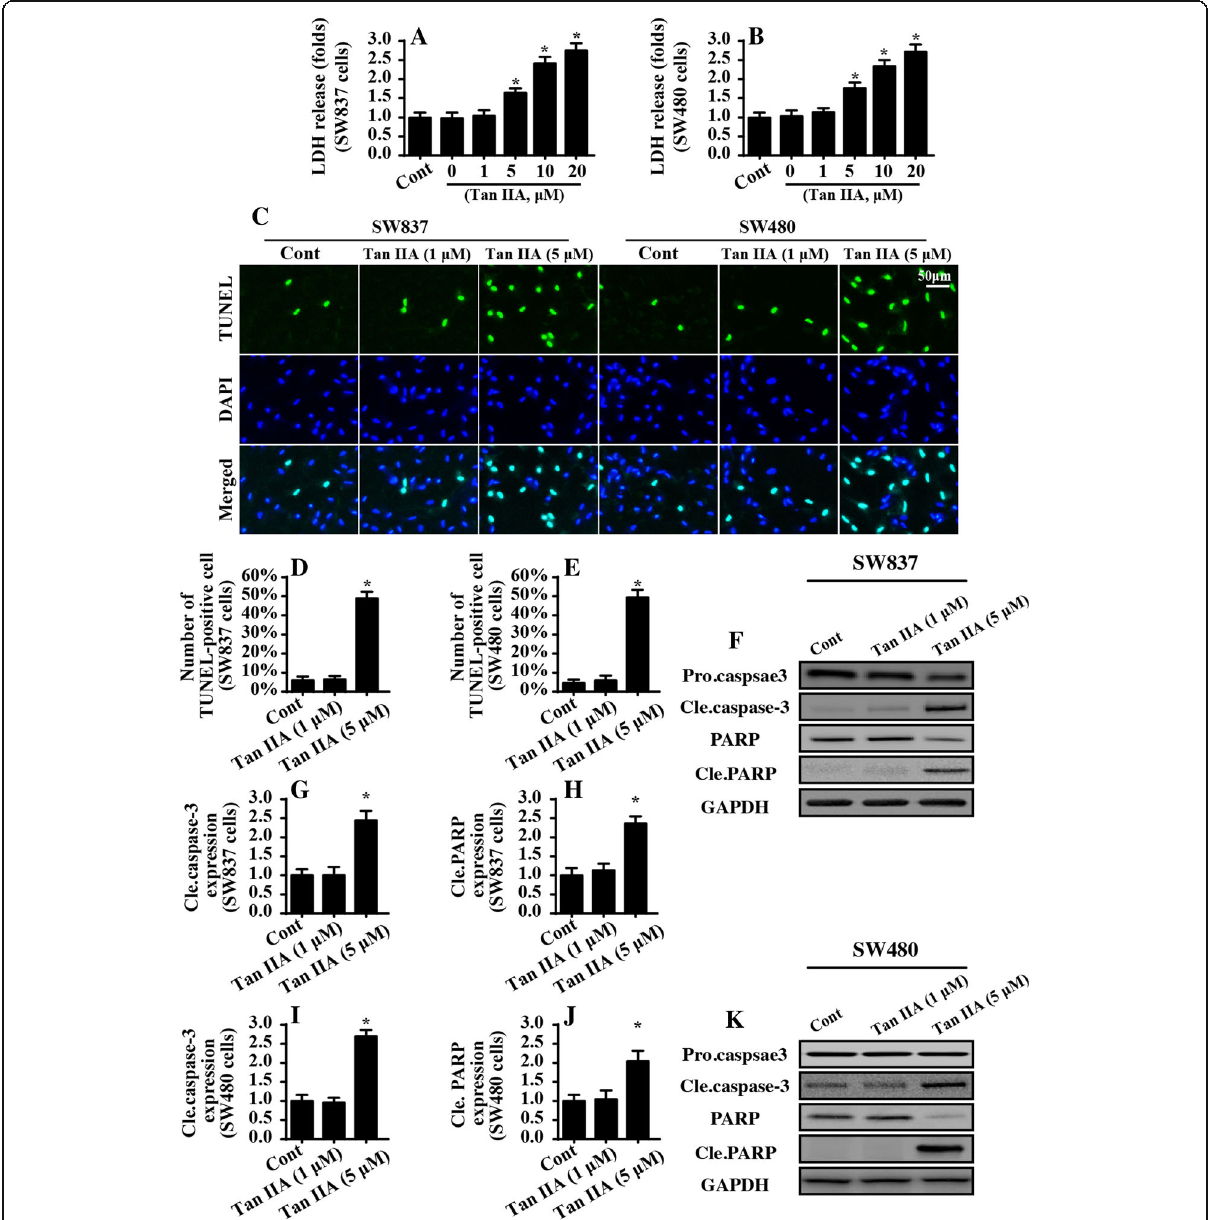
Fig. 1 Tan IIA dose-dependently induces cell death. a LDH release assay for cell death detection. The relative LDH release was measured in SW837 cells. Different doses of Tan IIA were added into the cell medium for 12 h. b LDH release assay in SW480 cells. c-e TUNEL staining for cell death. The number of TUNEL-positive cells was counted. Tan IIA at 1 μ M and 5 μ M were incubated with SW837 and SW480 cells for 12 h. f-k Western blotting was performed to analyze the protein expression relative to mitochondrial apoptosis. * p < 0.05 vs. control group